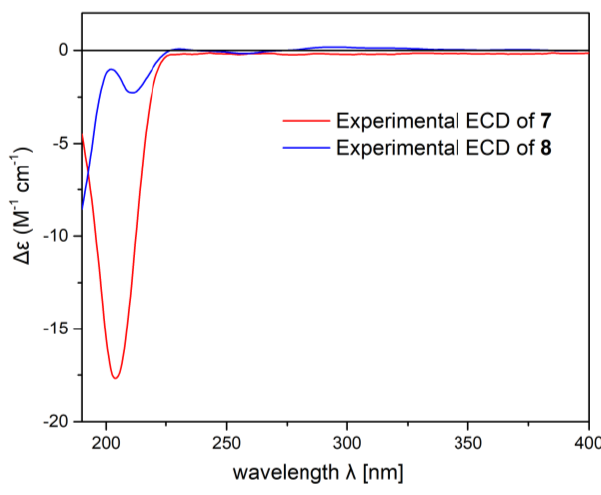
Figure 2. Experimental ECD spectra of compounds 7 (red) and 8 (blue) in MeCN. Sarcoxacyclol A ( 1 ), which was obtained as a colorless oil, possessed the molecular formula C 22 H 36 O 5 on the basis of its HRESIMS ion peak at m / z 403.2448 ([M+Na] + , calcd. for C 22 H 36 O 4 Na, 403.2455), requiring five degrees of unsaturation. As revealed by the 1 H and 13 C NMR data (Table 1), there were one disubstituted double bond [ δ H 5.55 (1H, d, J = 15.8 Hz, H-2) and 6.11 (1H, d, J = 15.8 Hz, H-3); δ C 129.8 (CH, C-2), 137.4 (CH, C-3)], one trisubstituted double bond [ δ H 5.42 (1H, dd, J = 4.3, 10.5 Hz, H-7); δ C 130.1 (CH, C-7), 132.1 (qC, C-8)], and one acetyl group [ δ H 2.00 (3H, s, H 3 -OAc); δ C 21.4 (CH 3 , C H 3 -OAc),